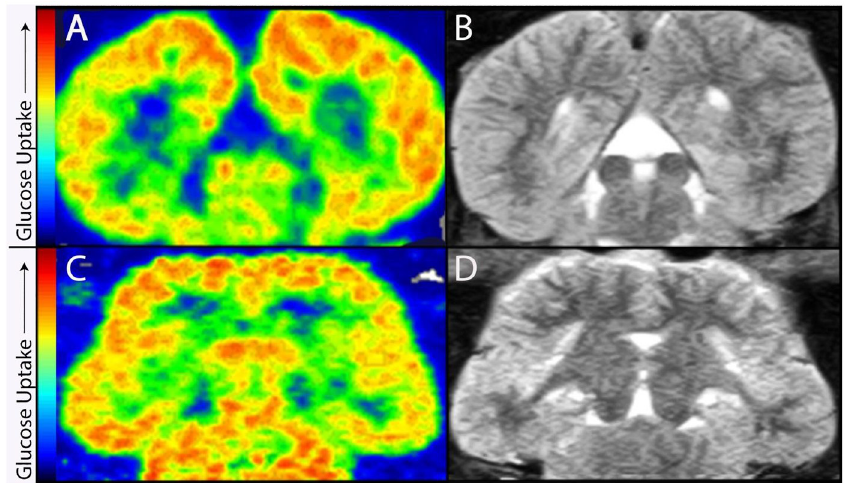
Fig 1. PET scans show that gray matter of the dolphin cerebrum and cerebellum have the highest metabolism in the brain. Frontal (A, B) and horizontal (C, D) views of a Tursiops truncatus brain after FDG PET (A, C) and MRI (B, D) scans. Images have been modified from previous publications with the authors’ permission [7,8]. The color map indicates the relative degree of glucose metabolism. The images demonstrate that high metabolic areas (i.e., areas of increased glucose consumption; red) are mainly concentrated in the gray matter of the cerebral cortex and cerebellum, with the exception of smaller sub-cortical nuclei (e.g., inferior colliculi; thalamic gray matter). The PET and MRI scans are from the same healthy dolphin that was trained to lie still in the